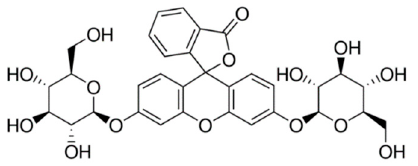
Figure 1. Chemical structure of fluorescein di-( β -D-glucopyranoside)-FbD.